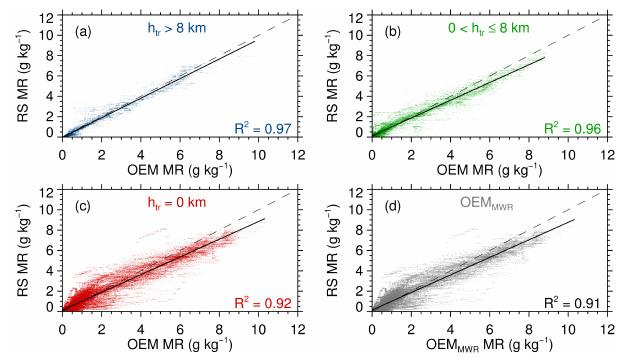
Figure 15. Mean difference (bias) between the retrieval and the RS (a) and a posteriori uncertainty (b) for two different absorp- tion codes: Rosenkranz, (R98, grey) and Liebe (L93, orange). The retrievals shown are based only on MWR but with different a priori states. On the one hand, both a priori profile and a priori uncertainty are taken from the RS climatology (theor.) and on the other hand the a priori profile is propagated (prop.) from the previous step while the uncertainty is taken from the RS climatology (red cases in the fig- ures above). The sample size is given by the numbers. Only profiles between RS launch time and 1h after launch time are considered.